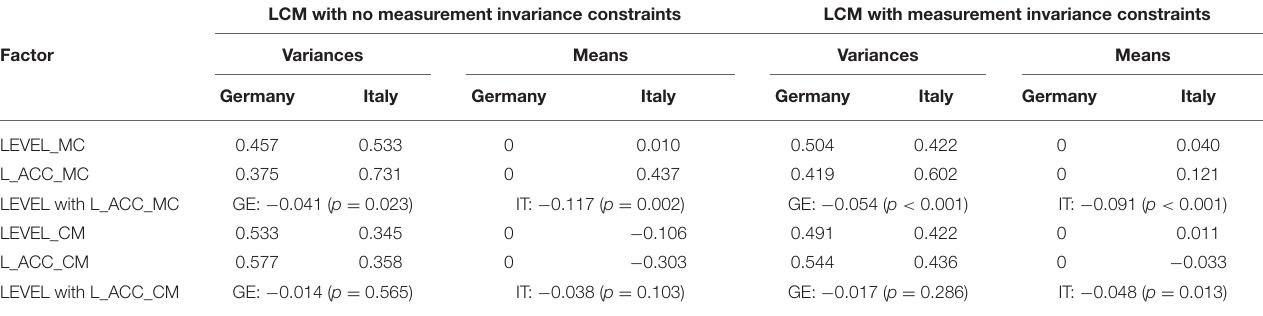
TABLE 8 | Variances and means of second-order factors for the accuracy models.